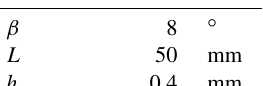
Table 4. Parameters of the quasi-zero stiffness stage.